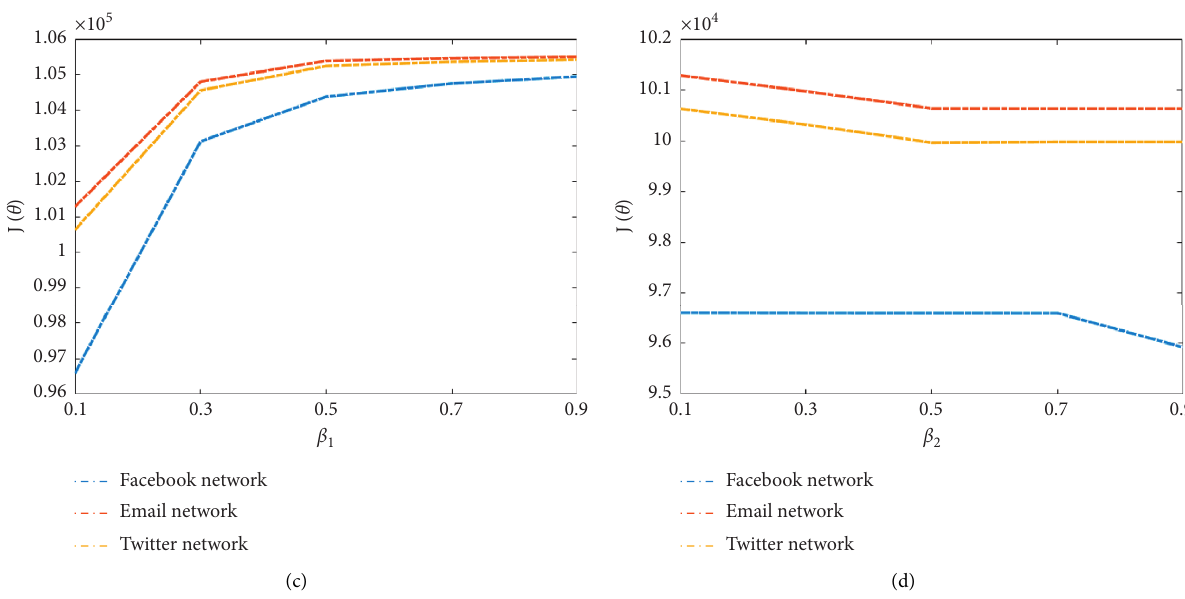
Figure 10: Parameters on the expected probability of buying for node 30: (a) ρ , (b) c , (c) β